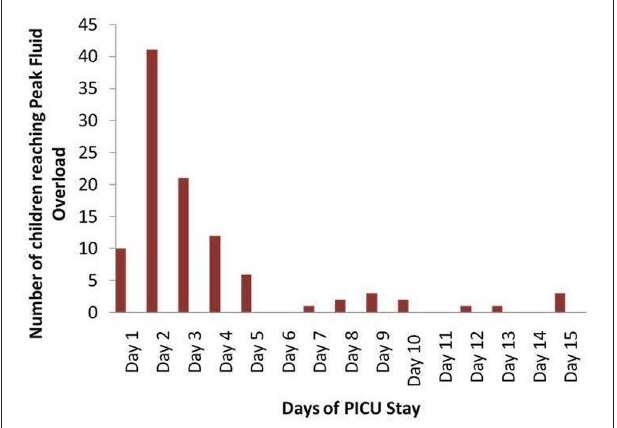
FIGURE 1 | Number of children reaching peak fluid overload on each day of ICU